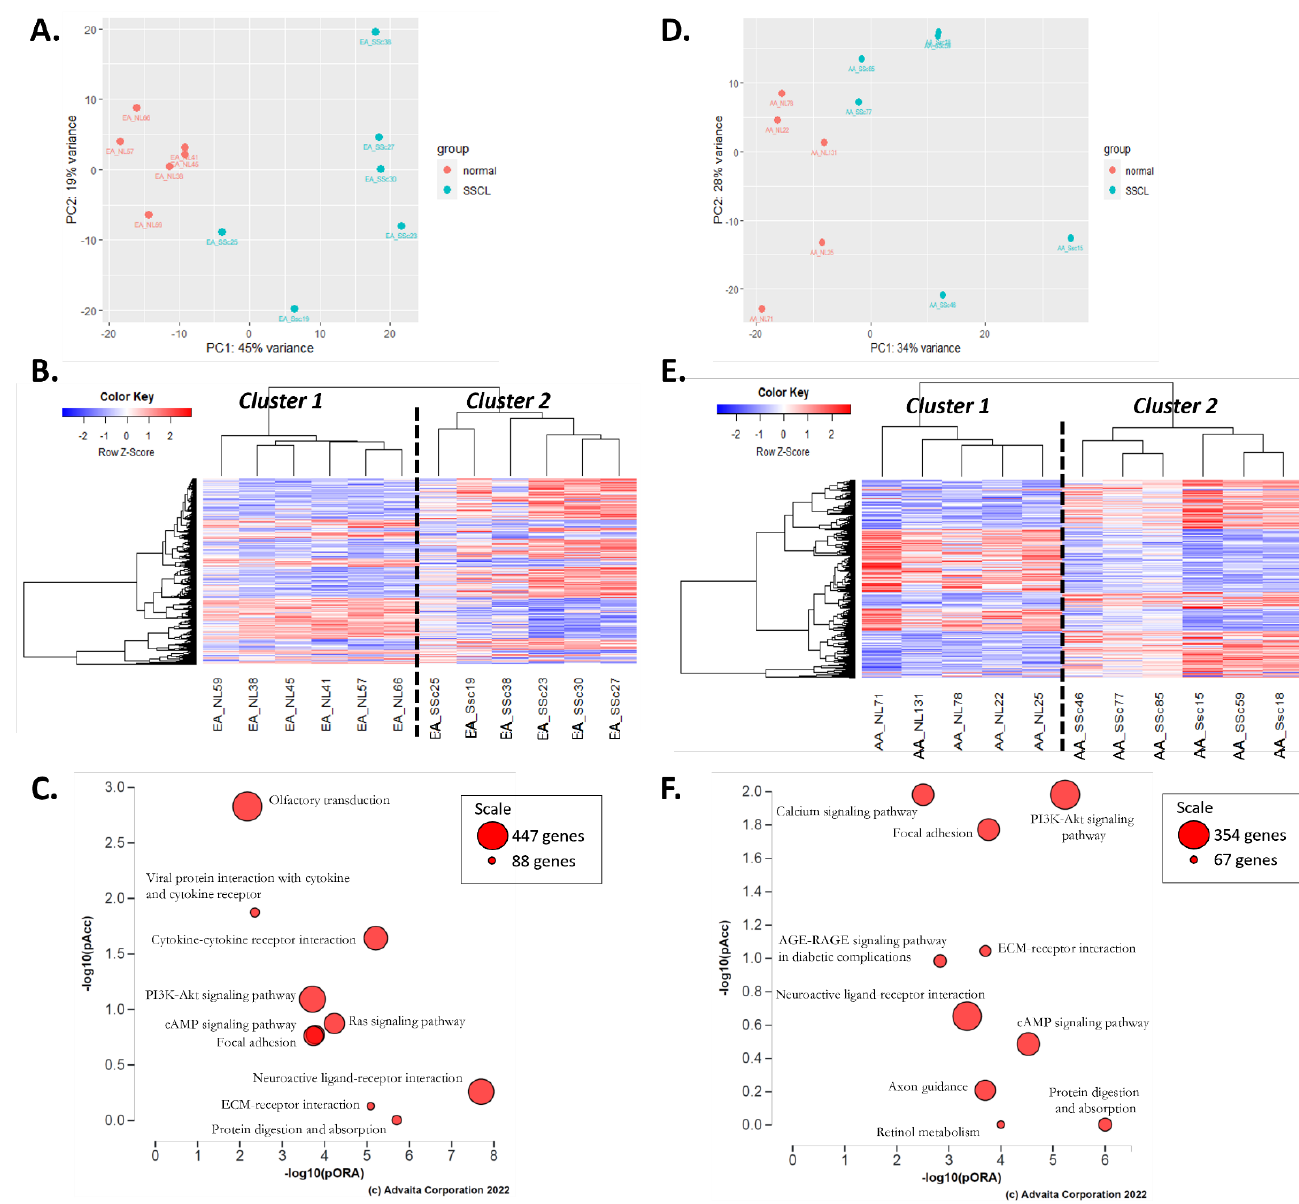
Figure 2. Results of the differential expression analyses “SScL vs. NL” in EA and AA. ( A ) PCA plot for “EA-SScL vs. EA-NL” DE analysis. ( B ) Heatmap of the genes with a q-value < 0.1 in the “EA-SScL vs. EA-NL” DE analysis. ( C ) Perturbation versus over-representation pathway plot for “EA-SScL vs. EA-NL” DE analysis. ( D ) PCA plot for “AA-SScL vs. AA-NL” DE analysis. ( E ) Heatmap of the genes with a q-value < 0.1 in the “AA-SScL vs. AA-NL” DE analysis. ( F ) Perturbation versus over-representation pathway plot for “AA-SScL vs. AA-NL” DE analysis. For panels ( C , F ): dots representing the top 10 impacted pathways are positioned by their p -values from the impact analysis measuring total perturbation accumulation (pAcc) and from the classic over-representation analysis (pORA). Red: significant combined p -values. The size of each dot denotes the total number of genes in the corresponding KEGG pathway (for visualization, this number is log(2)